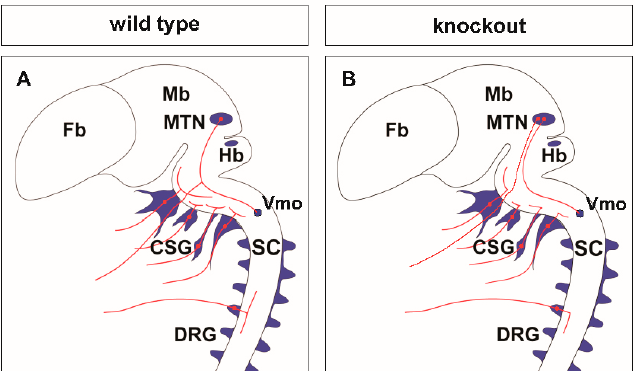
Figure 5. Scheme of neuronal circuits with sensory axon bifurcation in the wild type ( A ) or in the absence of bifurcation in CNP , Npr2 or cGKI null mutants ( B ). The lack of bifurcation affects the sensory representation of the body in the central nervous system (CNS). CSG, cranial sensory ganglia; DRG, dorsal root ganglia; Fb, forebrain; Hb, hindbrain; Mb, midbrain; MTN, mesencephalic trigeminal neuron; SC, spinal cord; Vmo, trigeminal motor nucleus.